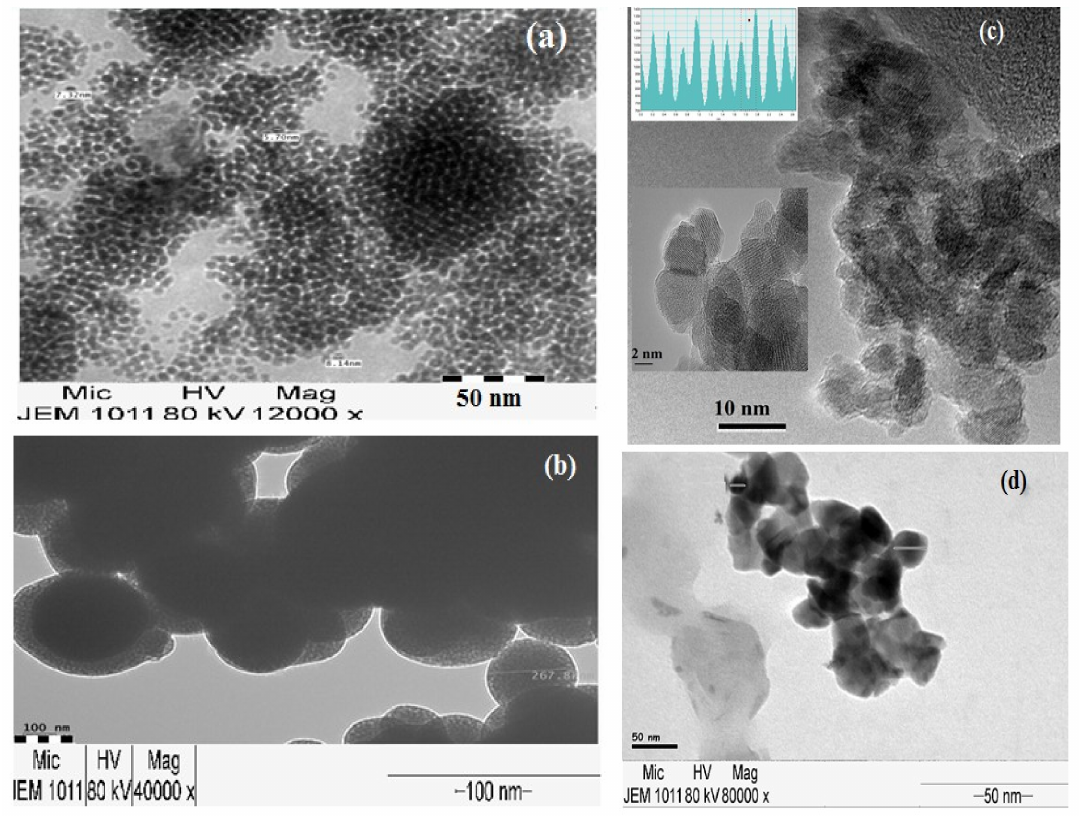
Figure 5. TEM micrographs of ( a ) Fe 3 O 4 NPs; ( b ) QVP / AAm; ( c ) QVP / AAm-Fe 3 O 4 ; ( d ) Fe 3 O 4 -QVP /